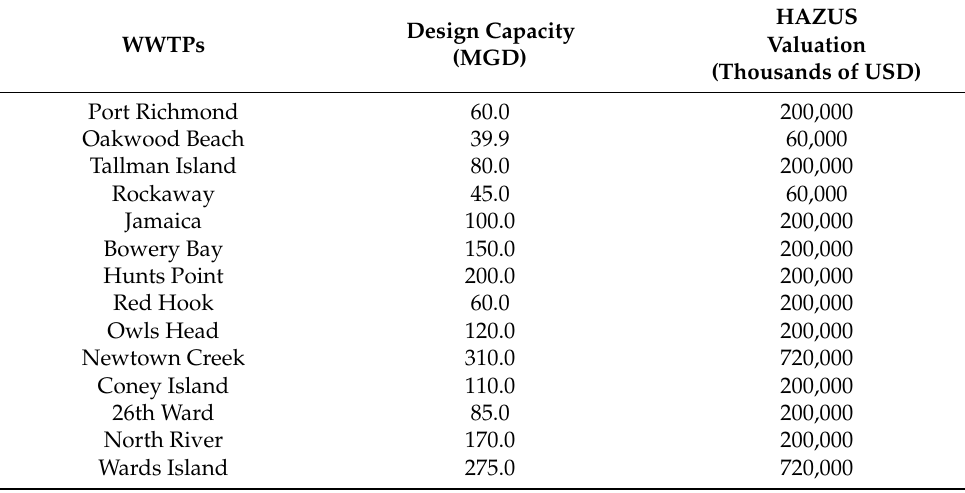
Table 3. HAZUS valuation and damage function of 14 WWTPs in NYC.